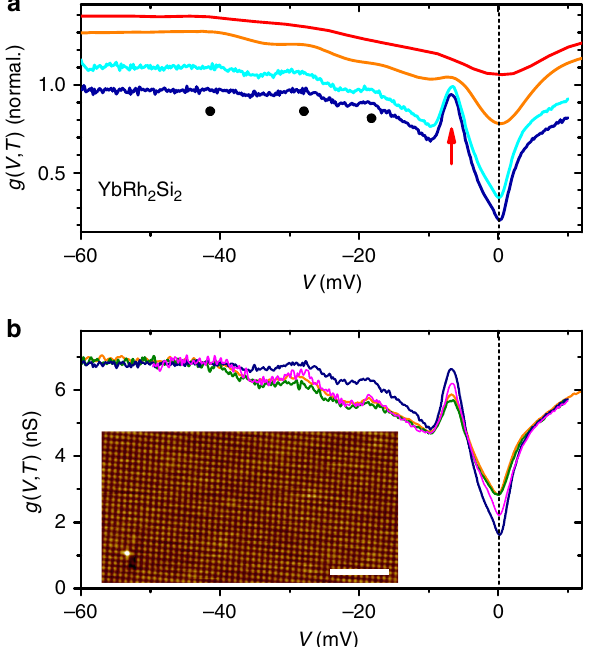
Fig. 2 Tunneling spectroscopy on YbRh 2 Si 2 . a Tunneling conductance g ( V , T ) normalized at V = − 80 mV and obtained at 0.3, 1.7, 5.5, and 30 K (from bottom to top), curves at 1.7, 5.5, and 30 K are offset for clarity. The − 6 meV-peak evolves strongly at low T (red arrow). Black dots mark features resulting from CEF splitting of the Yb 4 f multiplet. b g ( V , T )-curves at selected low T (blue: 0.3 K, magenta: 1 K, orange: 1.9 K, olive: 3.3 K) obtained on the Si-terminated surface shown in the inset. Inset: Topography indicating excellent surface quality (scale bar: 4 nm, V = 100 mV, I = 0.6 nA)